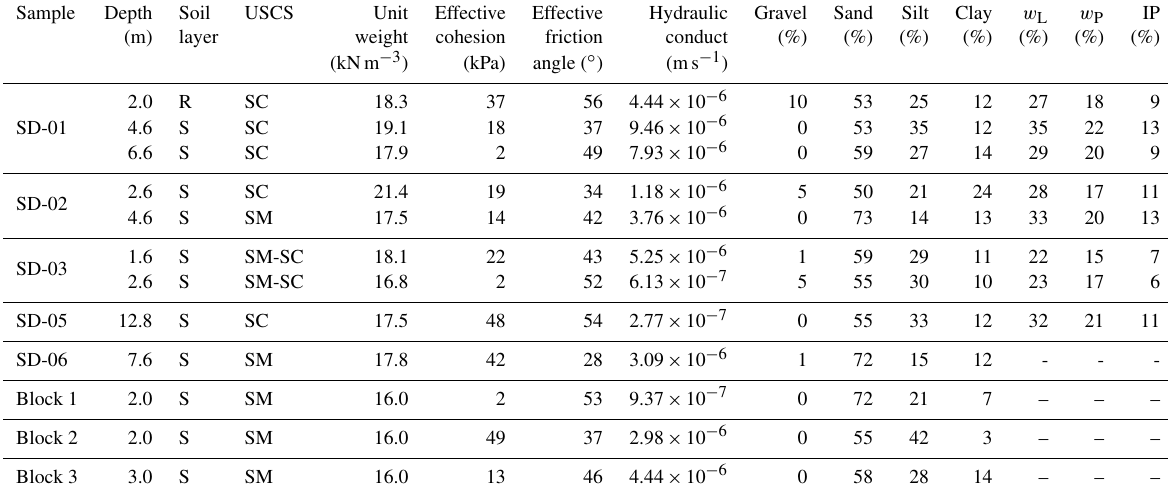
Fig. 7. Residual layer (sample SD-01/2.0 m) can be classi- fied as clayey sand, with percentages of sand and silt of 53 and 25 %. The soil samples representative of the saprolite layer showed a significant variation in the percentage of the